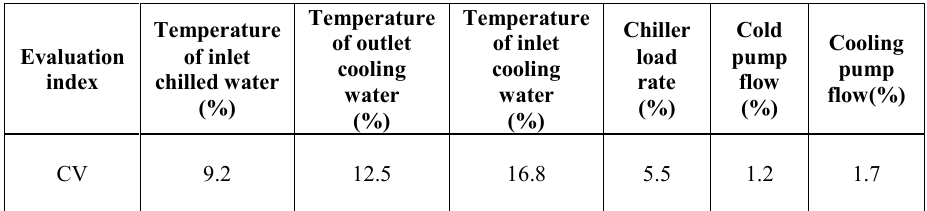
Table 1. Coefficient of variation (CV) of main